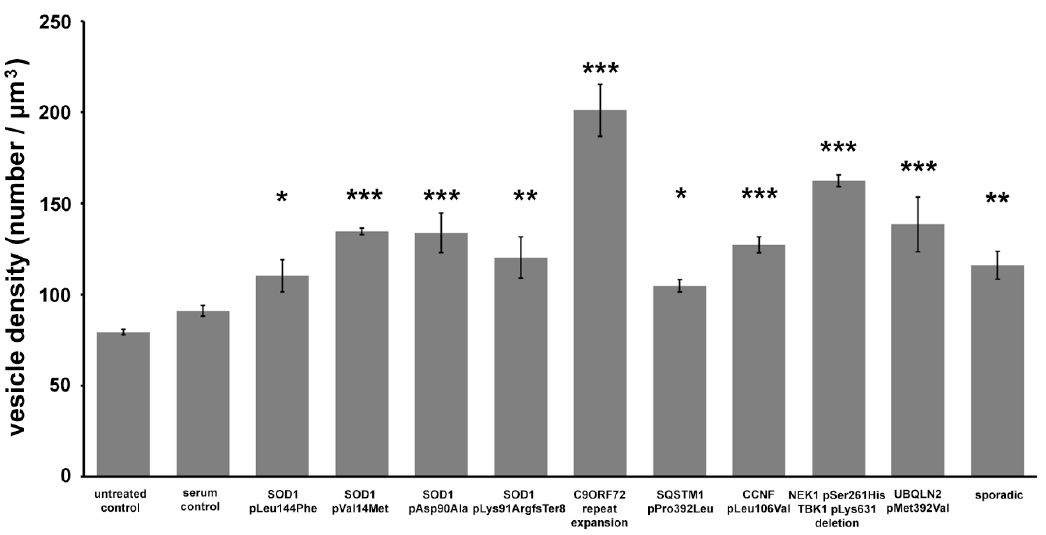
Figure 5. Volume density of synaptic vesicles in the active zones of neuromuscular synapses of mice inoculated with sera from amyotrophic lateral sclerosis (ALS) patients. All sera from ALS patients induced a significant increase in the number of active zone synaptic vesicles. Data are represented as the mean value ± standard error of the mean (s.e.m.). Statistical evaluation was determined using a one-way analysis of the variance (ANOVA) with the least significant difference post-hoc pairwise comparison. *: p < 0.05; **: p < 0.01; ***: p < 0.001.